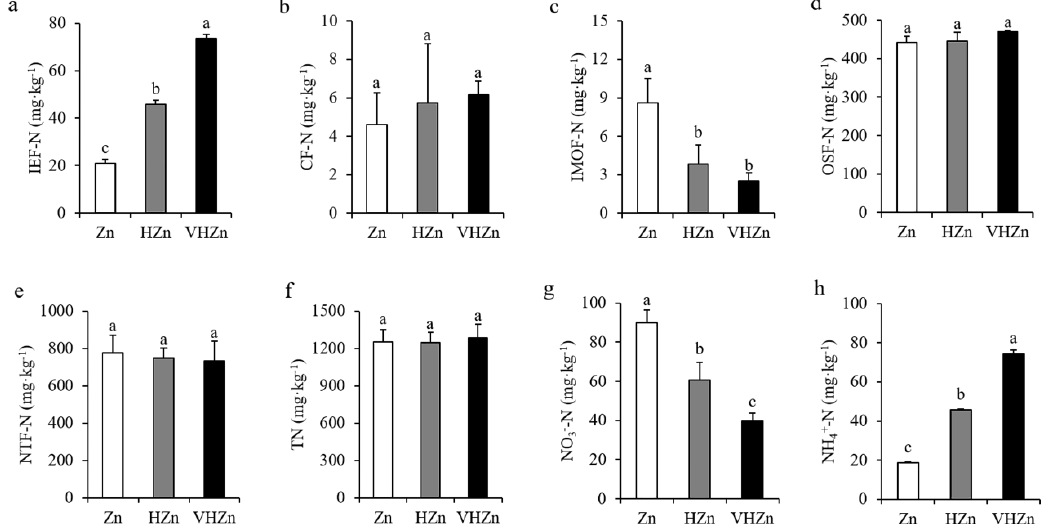
Figure 2. Concentrations of different N forms (( a ), IEF-N, ion exchanged nitrogen; ( b ), CF-N, car- bonate bounded nitrogen; ( c ), IMOF-N, iron-manganese oxide nitrogen; ( d ), OSF-N, organic sulfide bounded nitrogen; ( e ), NTF-N, non-transferable nitrogen; ( f ), T-N, total nitrogen; ( g ), NO 3− , nitrate; ( h ), NH 4+ , ammonium) in rice rhizosphere soil with different levels of Zn (Zn: 10 mg . kg −1 soil; HZn: 200 mg . kg −1 soil; VHZn: 400 mg . kg −1 soil). Data are means ± SD of three biological replicates. Differ- ent letters indicate significant difference at p < 0.05 by Tukey’s test.